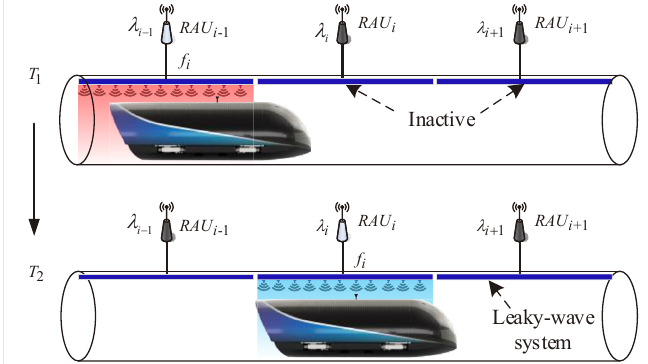
Figure 8. Basic principle to implement moving frequency